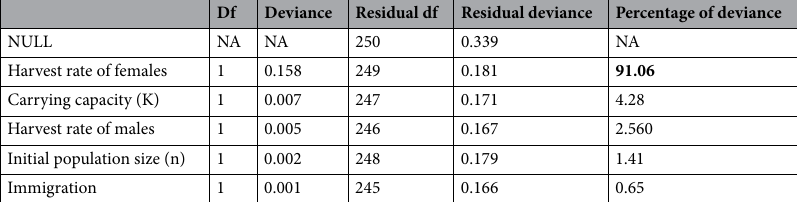
Table 4. Percentage of deviance explained by each predictor variable in generalised linear models where population growth rate was the response variable for broad-headed snake populations in Morton National Park, New South Wales, Australia. Emboldened percentage deviance identifies harvest rate of females as explaining the majority of deviance in the model and having the largest effect on stochastic growth rate.